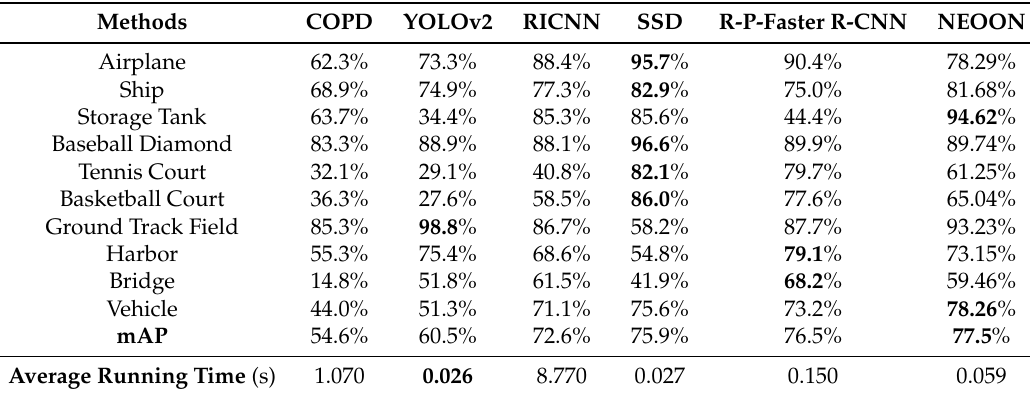
Table 3. Comparison of performance on NWPU VHR-10